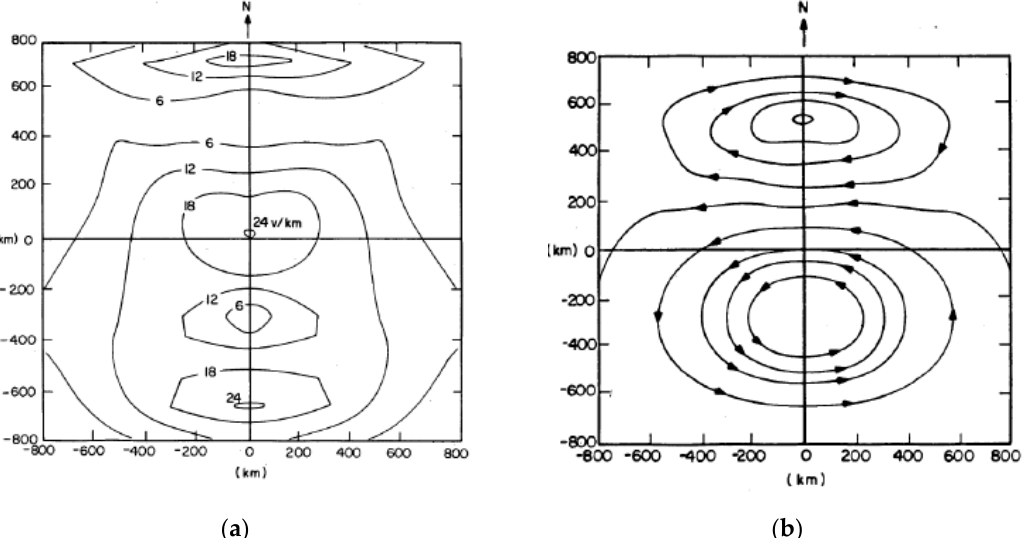
Figure 3. Spatially varying time-invariant magnitude and direction of the electric field in the model proposed by the ORNL for the E3-HEMP-generated electric field: ( a ) Spatially varying time-invariant electric field magnitude ε ( x , y ); ( b ) Spatially varying time-invariant electric field direction e ( x , y ) [11]. [Courtesy of Oak Ridge National Laboratory, U.S. Dept. of Energy]